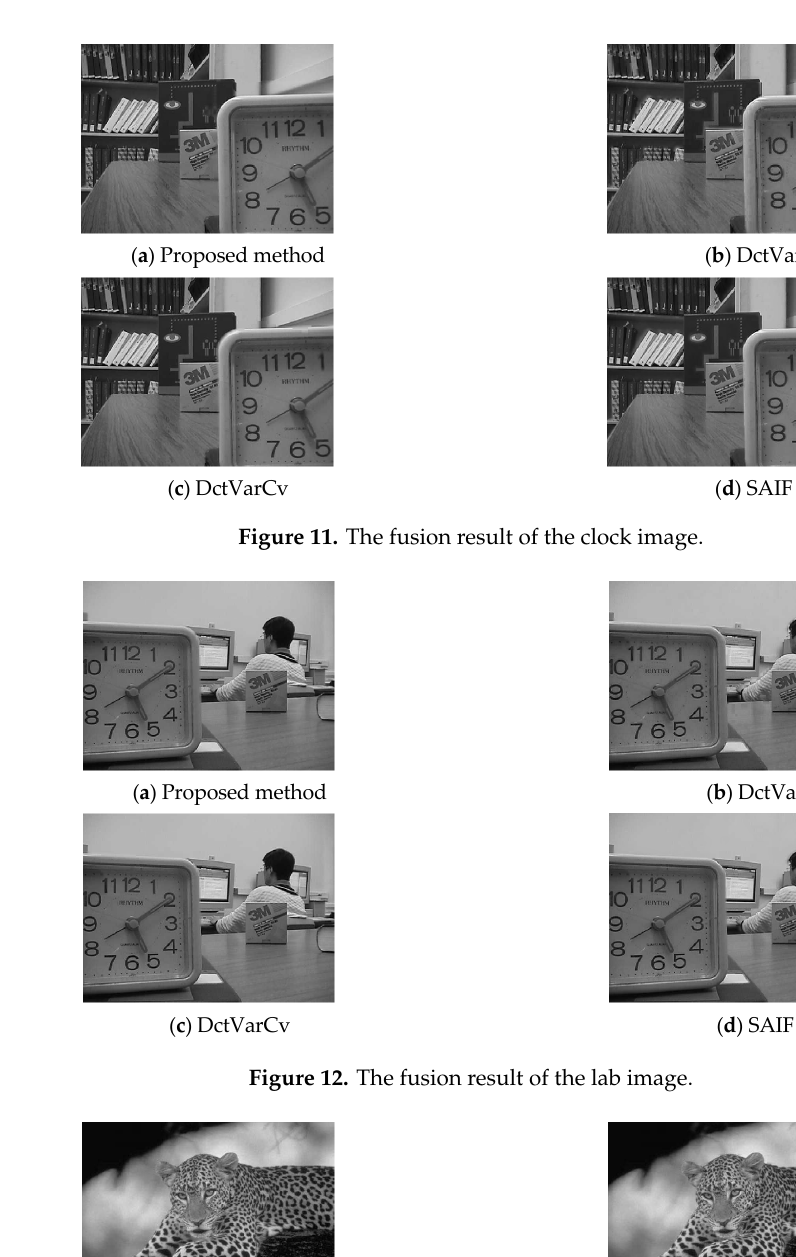
Figure 10. The fusion result of the clock image.